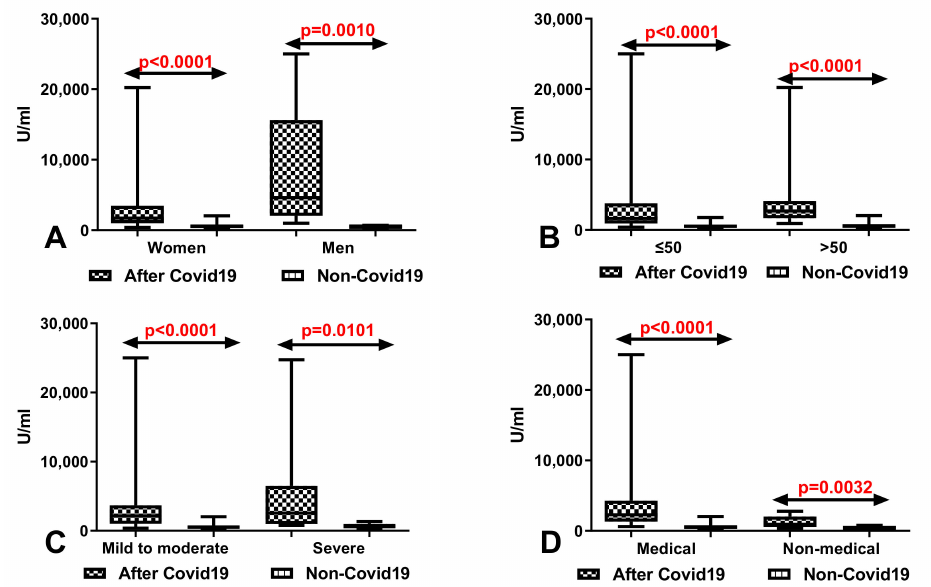
Figure 3. ( A ) Comparison of total anti-SARS-CoV-2 antibodies level in the groups of women and men with and without history of COVID-19. The data are presented as median (minimum–maximum). ( B ) Comparison of total anti-SARS-CoV-2 antibodies level in groups of patients before and after the age of 50 with and without history of COVID-19. The data are presented as median (minimum– maximum). ( C ) Comparison of total anti-SARS-CoV-2 antibodies level in groups of patients with mild to moderate and severe symptoms after vaccination with and without history of COVID-19. The data are presented as median (minimum–maximum). ( D ) Comparison of total anti-SARS-CoV-2 antibodies level in groups of medical and non-medical workers with and without history of COVID-19. The data are presented as median